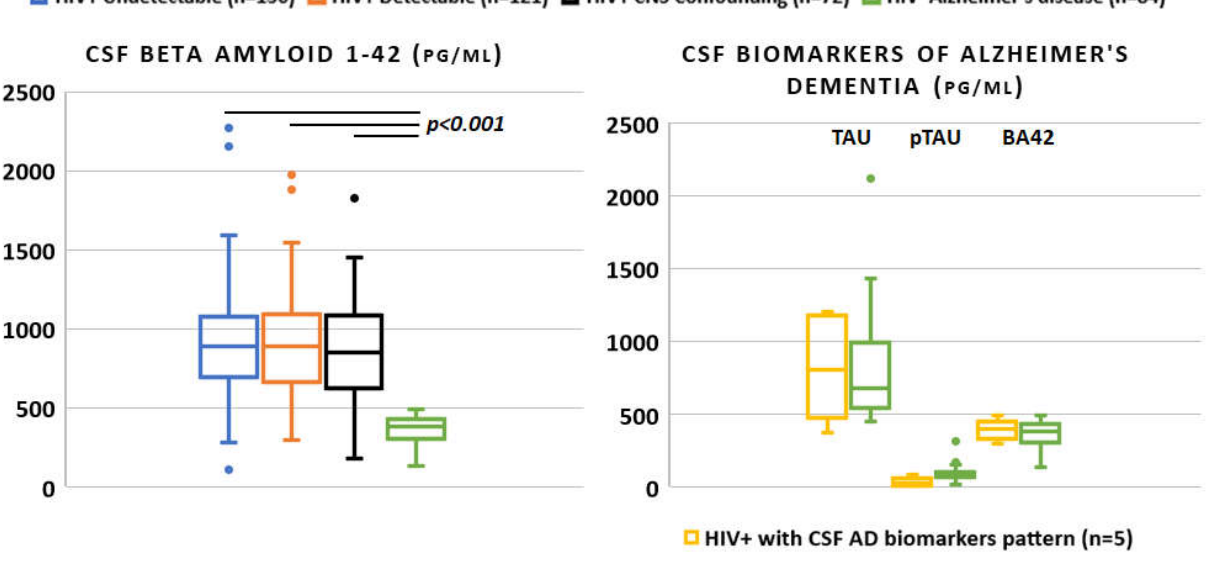
Figure 2. Alzheimer’s disease cerebrospinal fluid biomarkers across the spectrum of HIV infection and in negative controls (only p -values < 0.05 for the one-to-one group comparisons were reported). In patients with undetectable viremia, tau correlated with ptau (rho 0.679, p < 0.0005), BA42 (rho 0.351, p < 0.0005), CSAR (rho 0.313, p < 0.0005), age (rho 0.472, p < 0.0005;